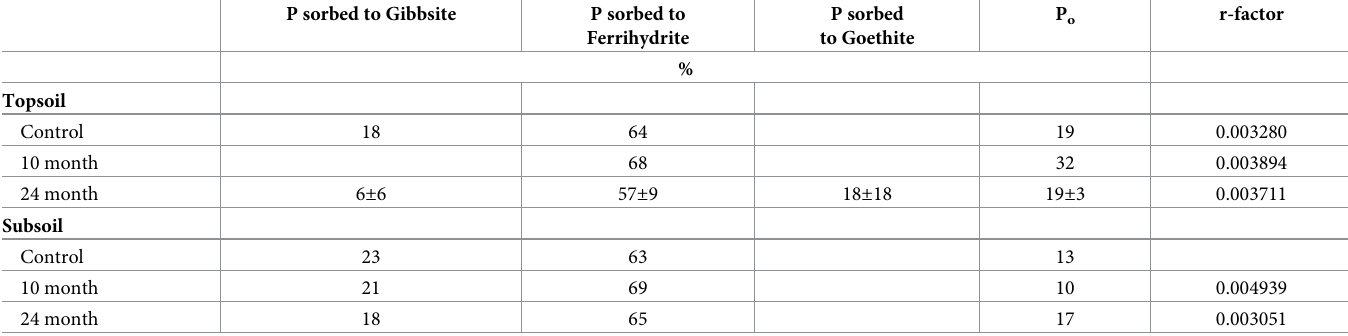
Table 6. Results of linear combination fitting of P K -edge XANES spectra of forest soil microaggregates size fraction of the control without clear-cut, 10, and 24 month after clear-cut. Values in brackets shown the standard deviation of averaged fit proportions in the case when fits were not significantly different to each other (Hamilton P � 0.05) based on the r-factor.